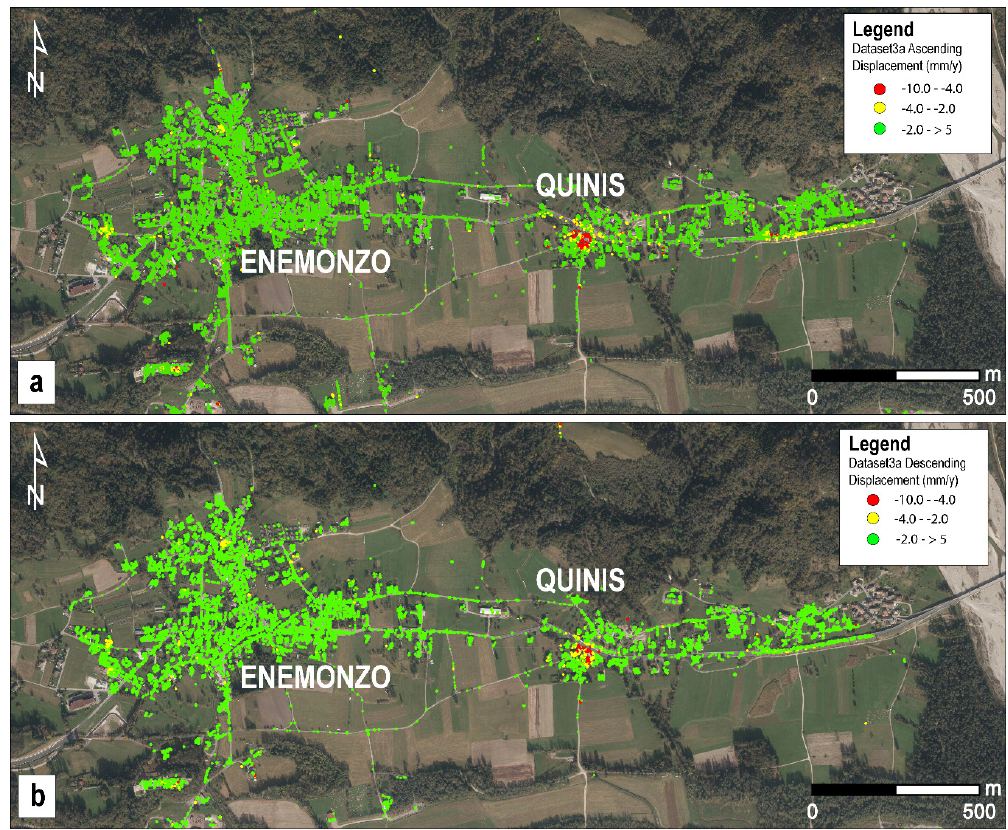
Figure 9. Average velocity of movement of the PS (mm/y) with reference to the entire observation period. The estimated velocity is projected along the line of sight of the satellite. ( a ) Ascending geometry (18 February 2012–08 September 2016); ( b ) descending geometry (01 January 2012–08 September 2016). In red, negative values highlighting high downward deformations; in green, positive values highlighting upward deformations and stable